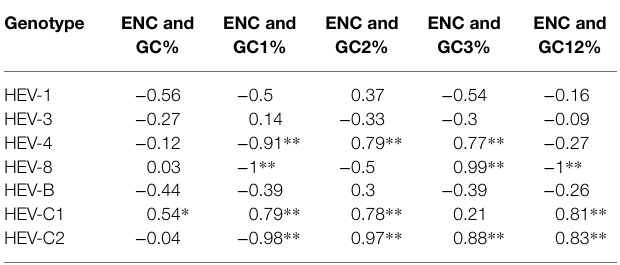
TABLE 4 | Correlation analysis between ENC and GC contents of HEV complete coding